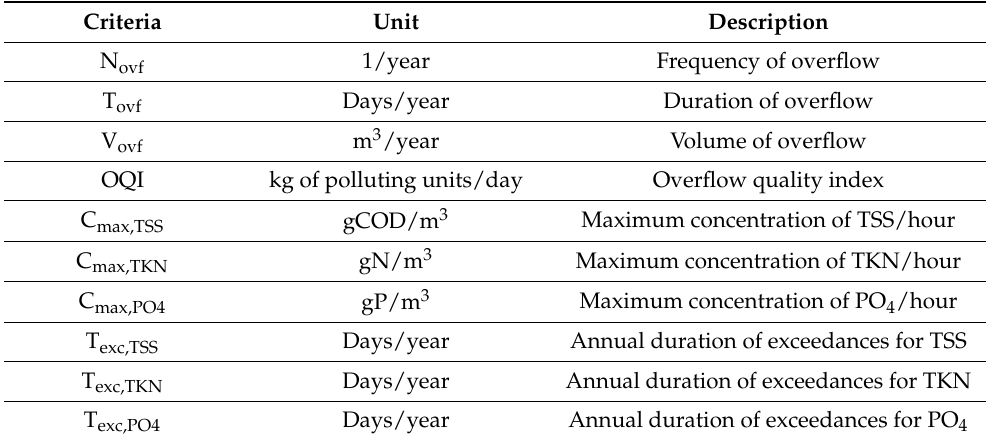
Table 5. Performance